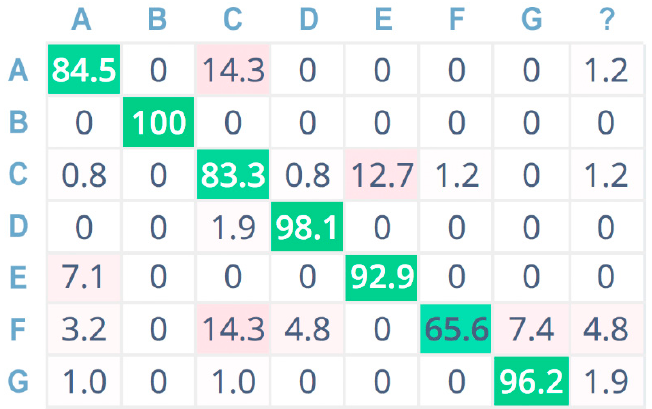
Figure 10. Confusion matrix adopting Mel spectrogram pre-processing, 32 bit.